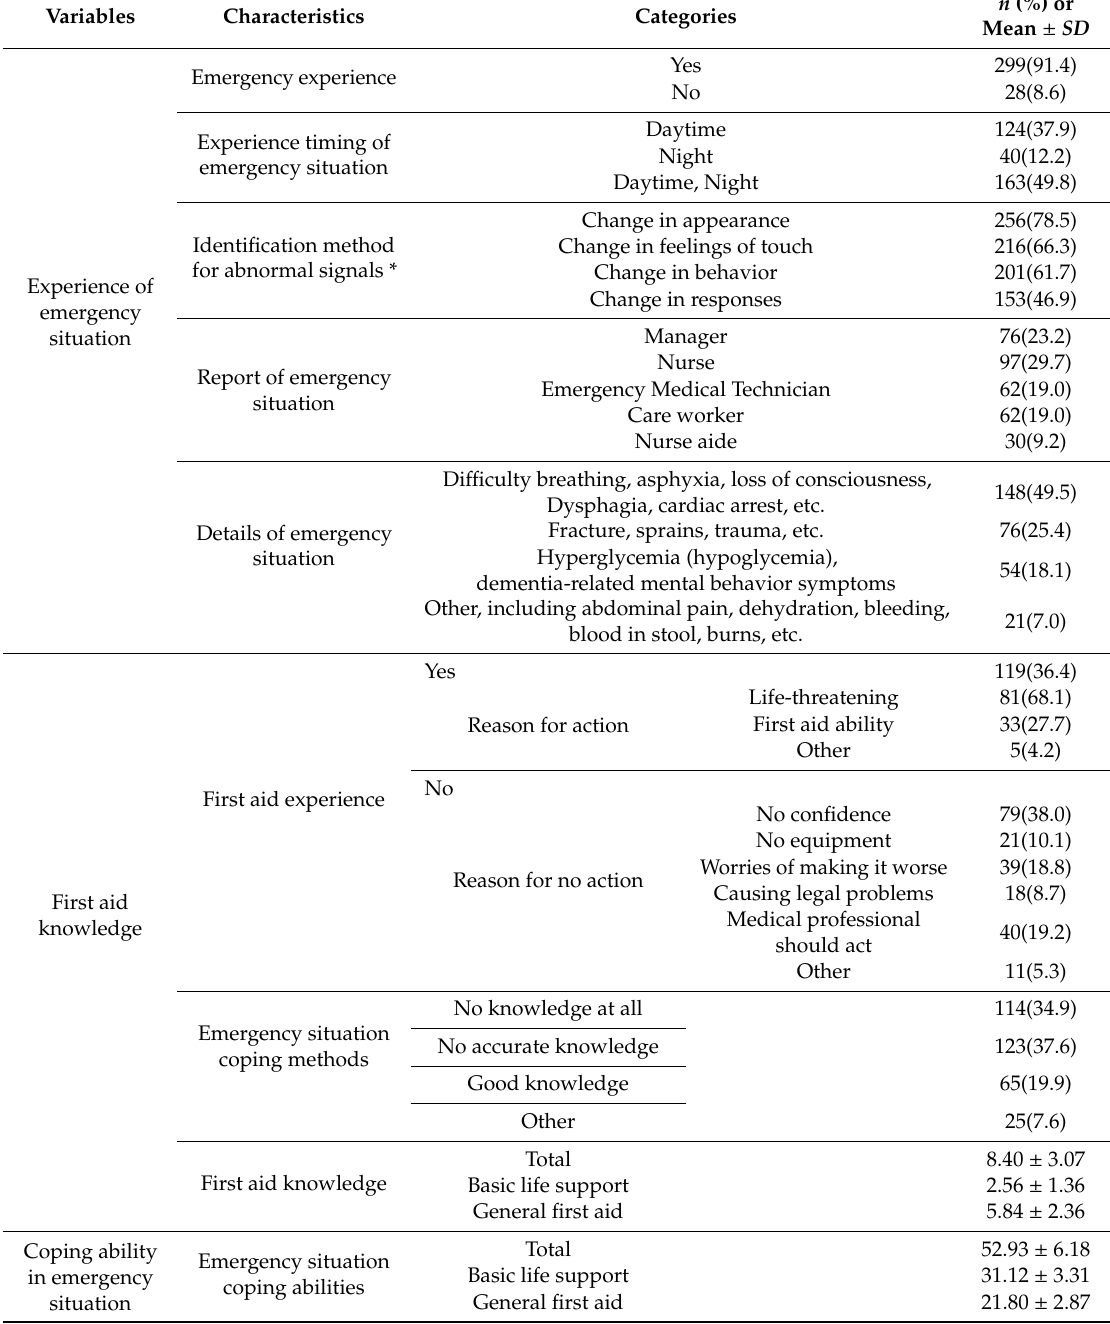
Table 2. Emergency situation experience, first aid knowledge, and emergency coping abilities ( N =